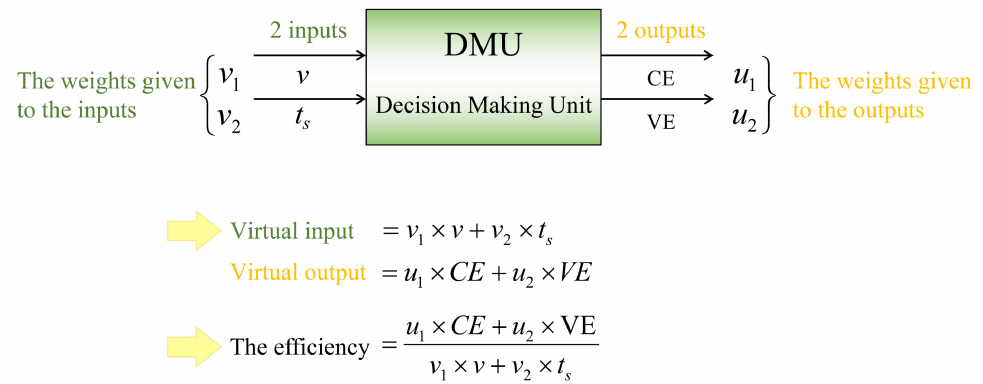
Figure 6. Evaluation model for each